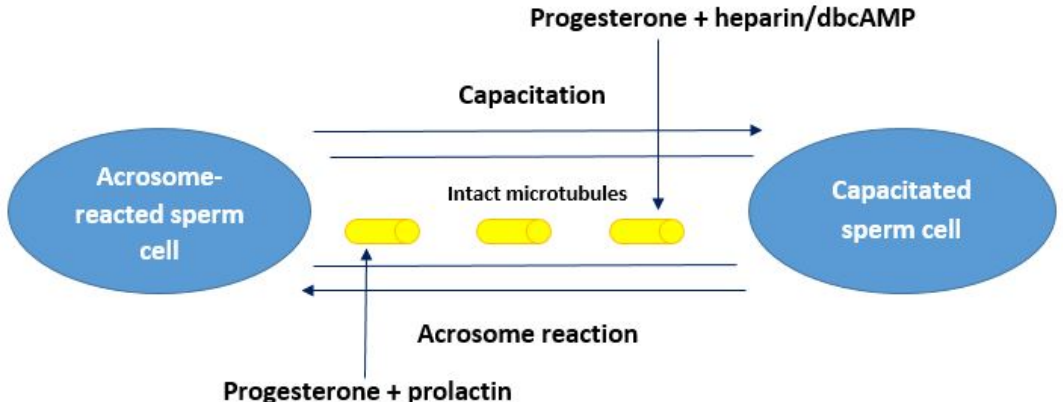
Figure 7. The effect of progesterone on functional status of native bovine spermatozoa. In the presence of progesterone in native bovine spermatozoa, dbcAMP and heparin induce the process of capacitation in spermatozoa at the acrosome reaction stage, while prolactin stimulate the acrosome reaction in capacitated cells; both reactions go through the intact microtubules.